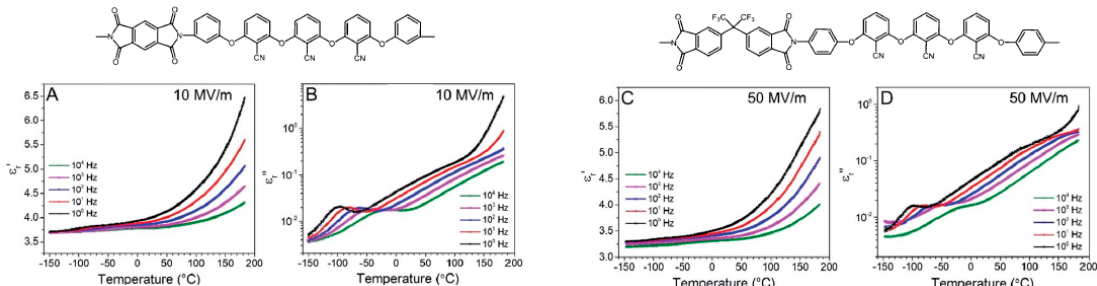
Figure 4. Dependence of the real part of the relative permittivity ( ε ’) and dielectric loss ( ε ’’) on the temperature for poly(amide) samples under a high-strength electric field with peak amplitudes of 10 MV m − 1 and 50 MV m − 1 . Adapted from reference [10] with permission. Copyright 2014, Royal Society of Chemistry.